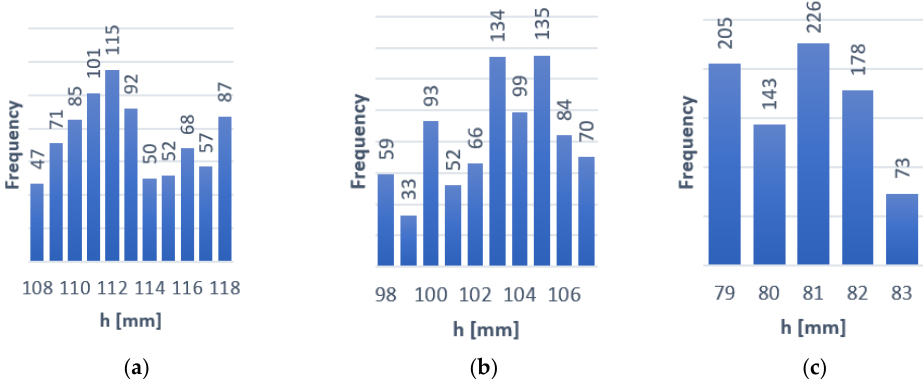
Table 2. Results of adopted control quality criteria. Figure 11. PID Distribution, ( a ) compartment 1, ( b ) compartment 2, ( c ) compartment 3